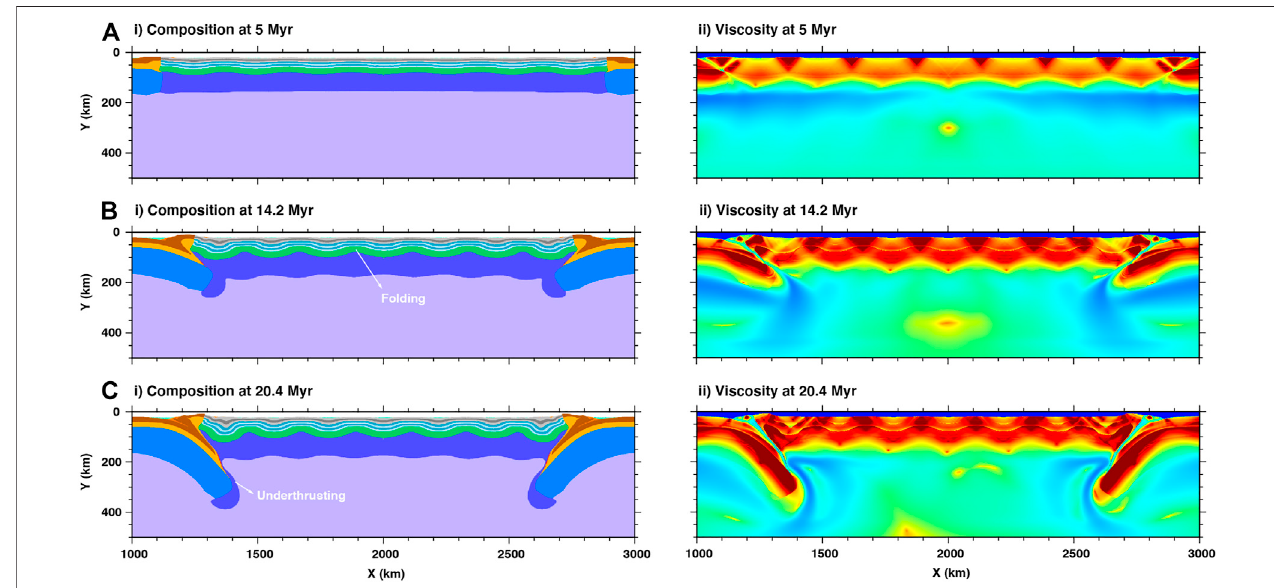
FIGURE 5 | Time evolution of the model “ delf ” , in which the orogen lower crust rheology is represented by ‘ diabase ’ . (Ai – Ci) composition evolution for selected model times (colors as in Figure 2 ). (Aii – Cii) viscosity distribution for selected model times (colors as in Figure 3 ).